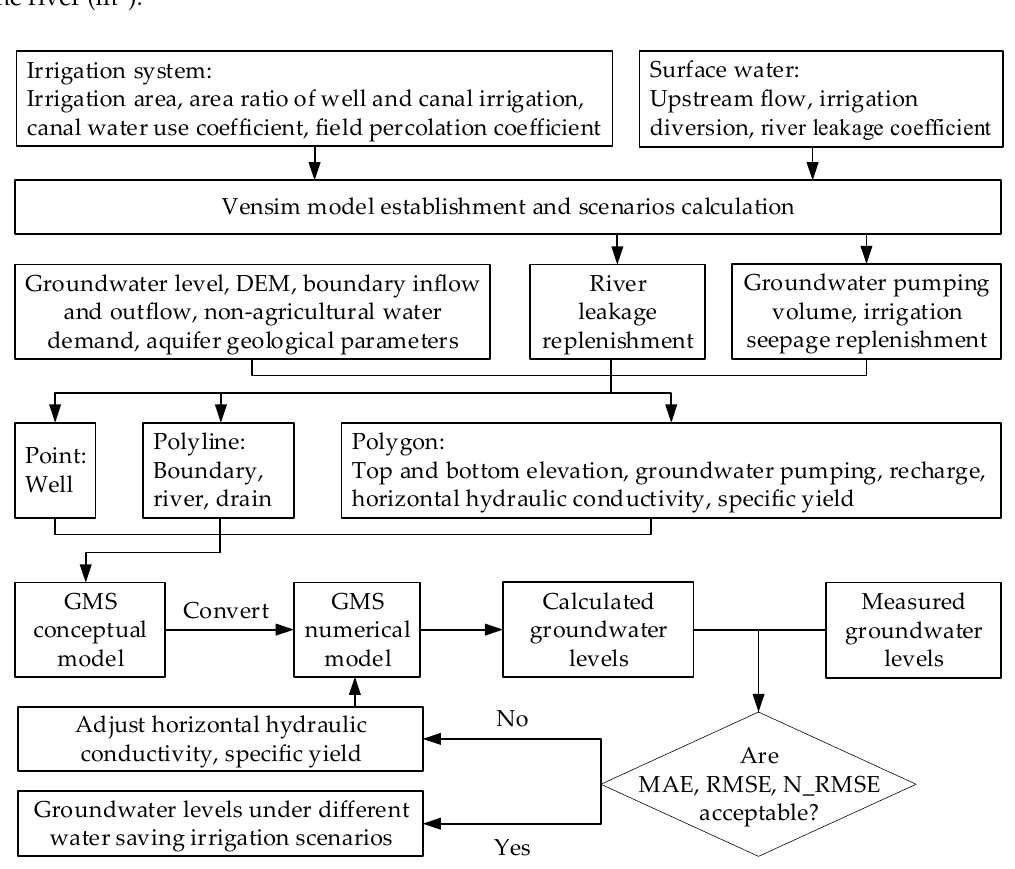
Figure 3. Schematic structure of the applied model.